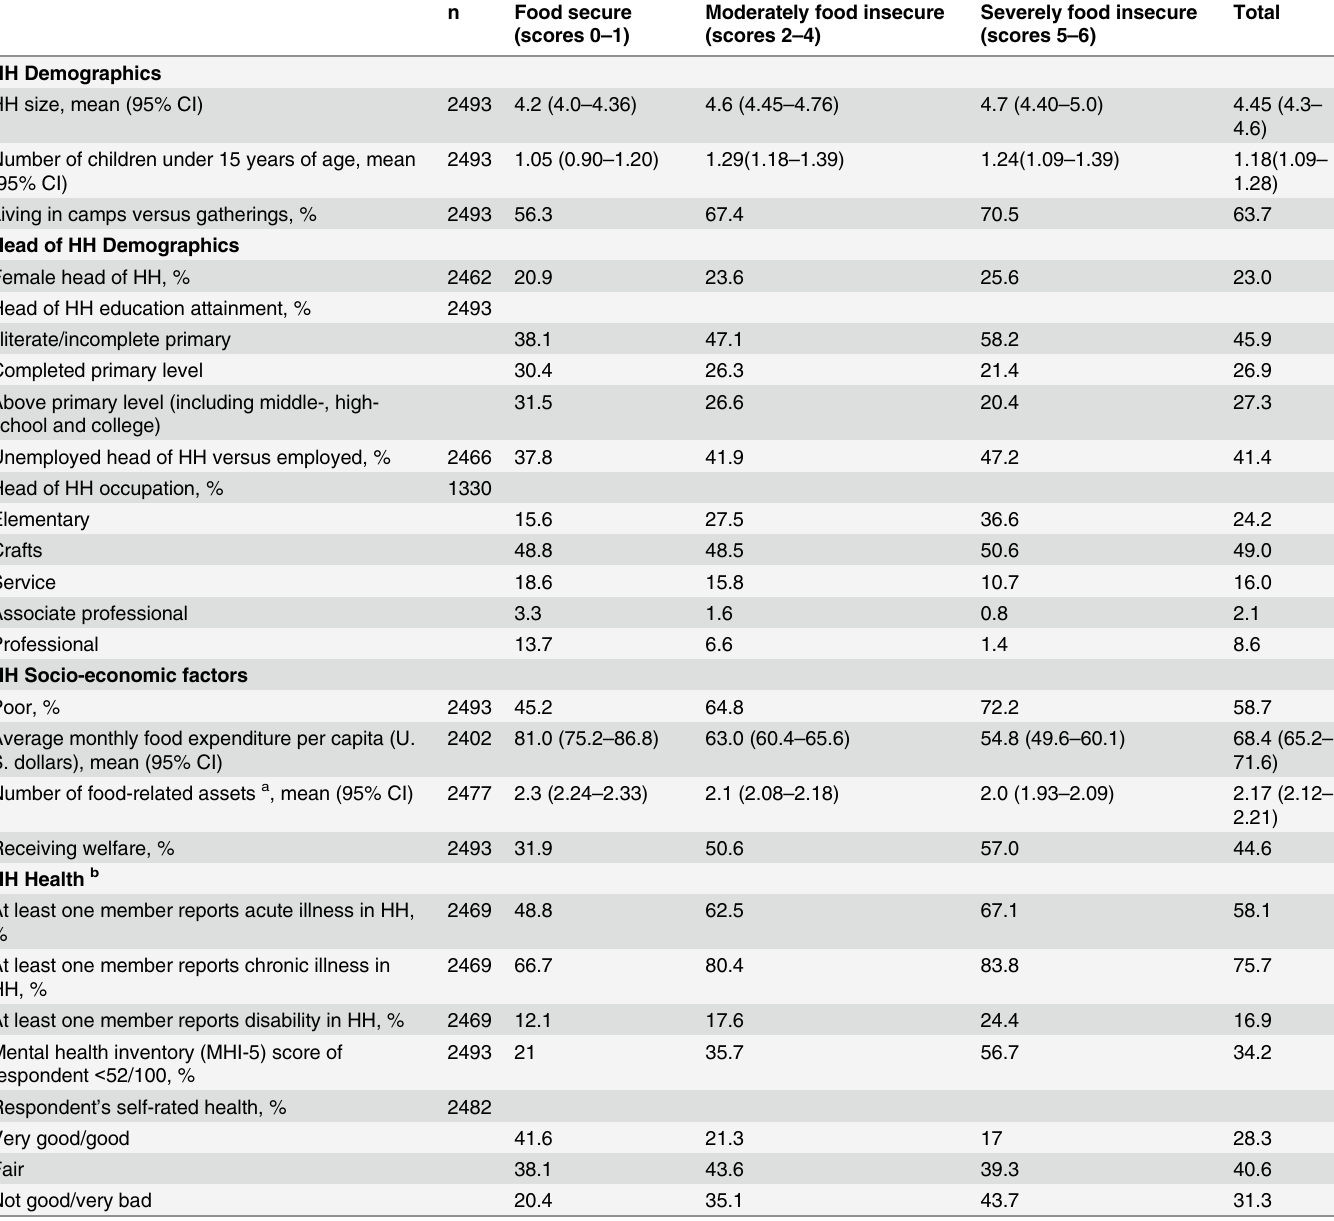
Table 1. Characteristics of Palestinian refugees by levels of household (HH) food